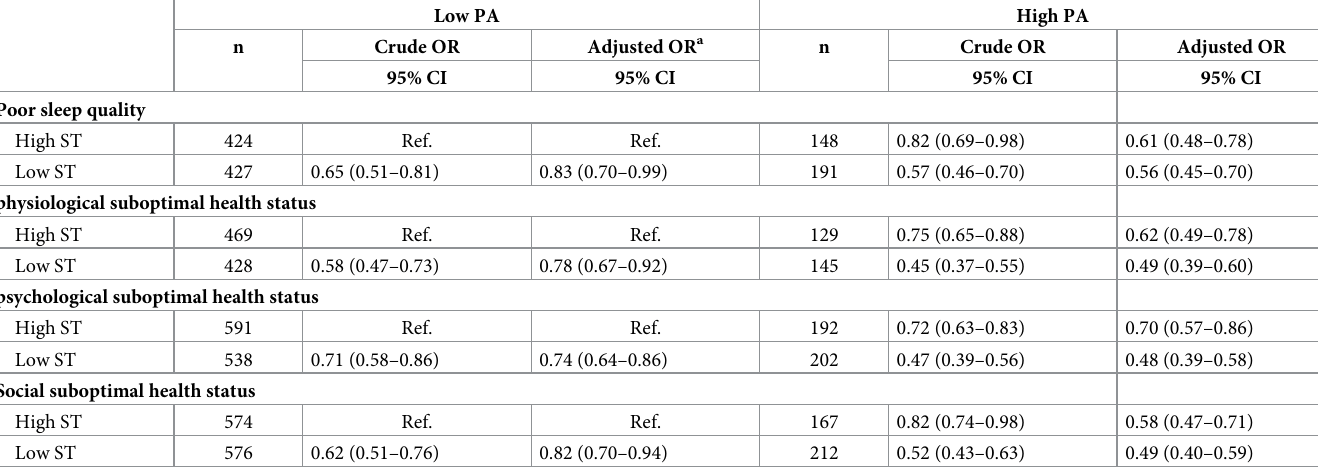
Table 3. Interactive associations between ST, PA and sleep quality, and physiological, psychological, and social suboptimal health status. Low PA High